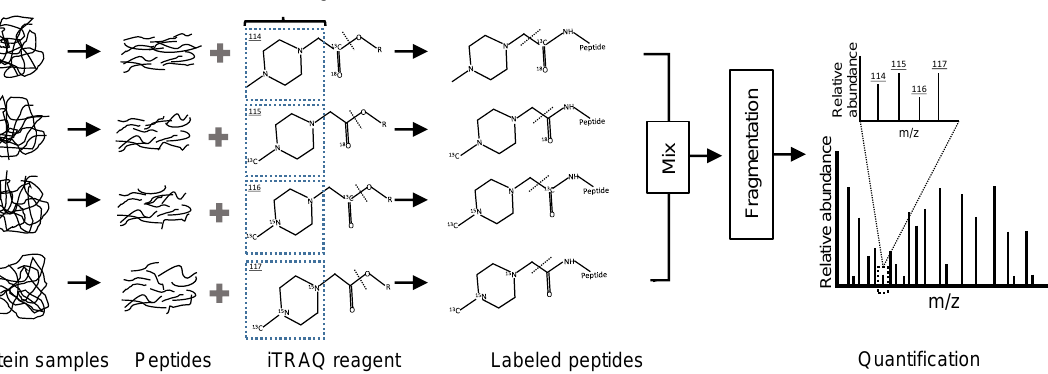
Figure 2. Common 4-plex isobaric tags for relative and absolute quantitation (iTRAQ) workflow. The reporter group (isobaric tag) tends to fall off upon fragmentation and generates ions of different molecular mass (i.e., m / z from 114 to 117), and common to other isobaric and isotopic labelling, is the downstream processing where the labelled peptide ratios are computed, and then statistically assessed to evaluate the assembled protein ratios (Mueller et al . 2008).